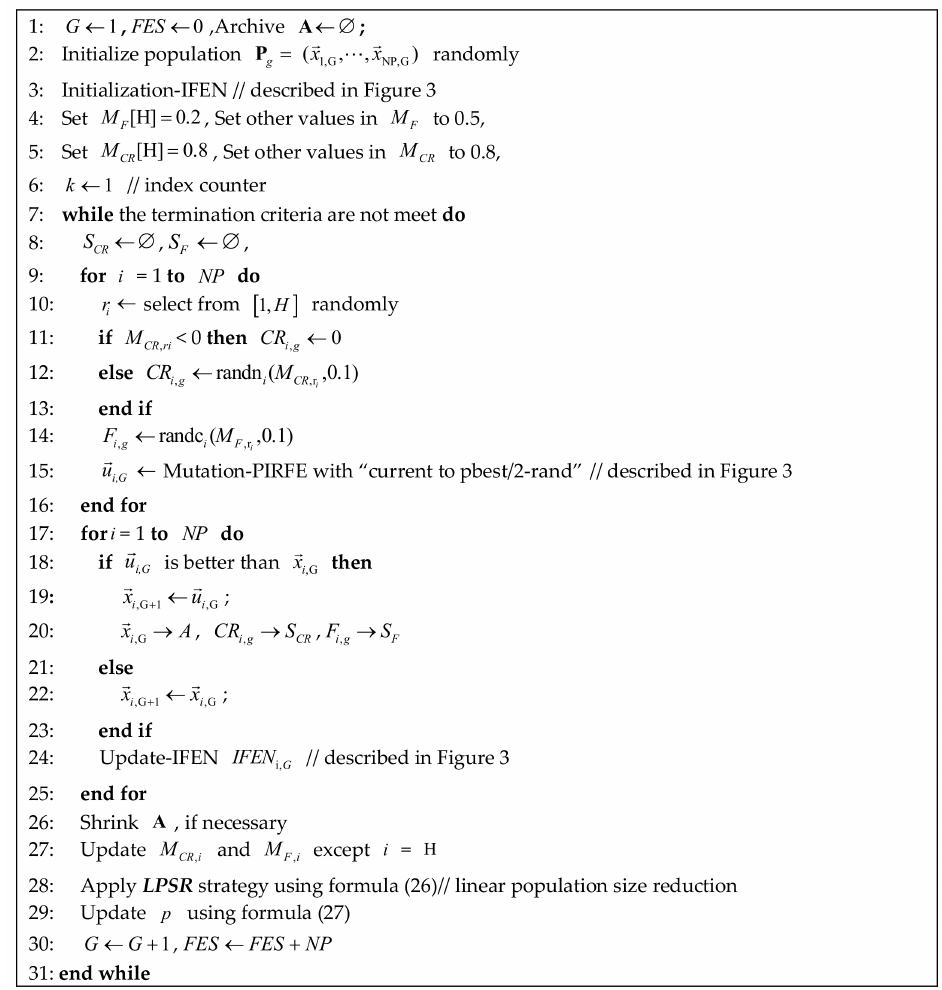
Figure 4. Pseudocode of